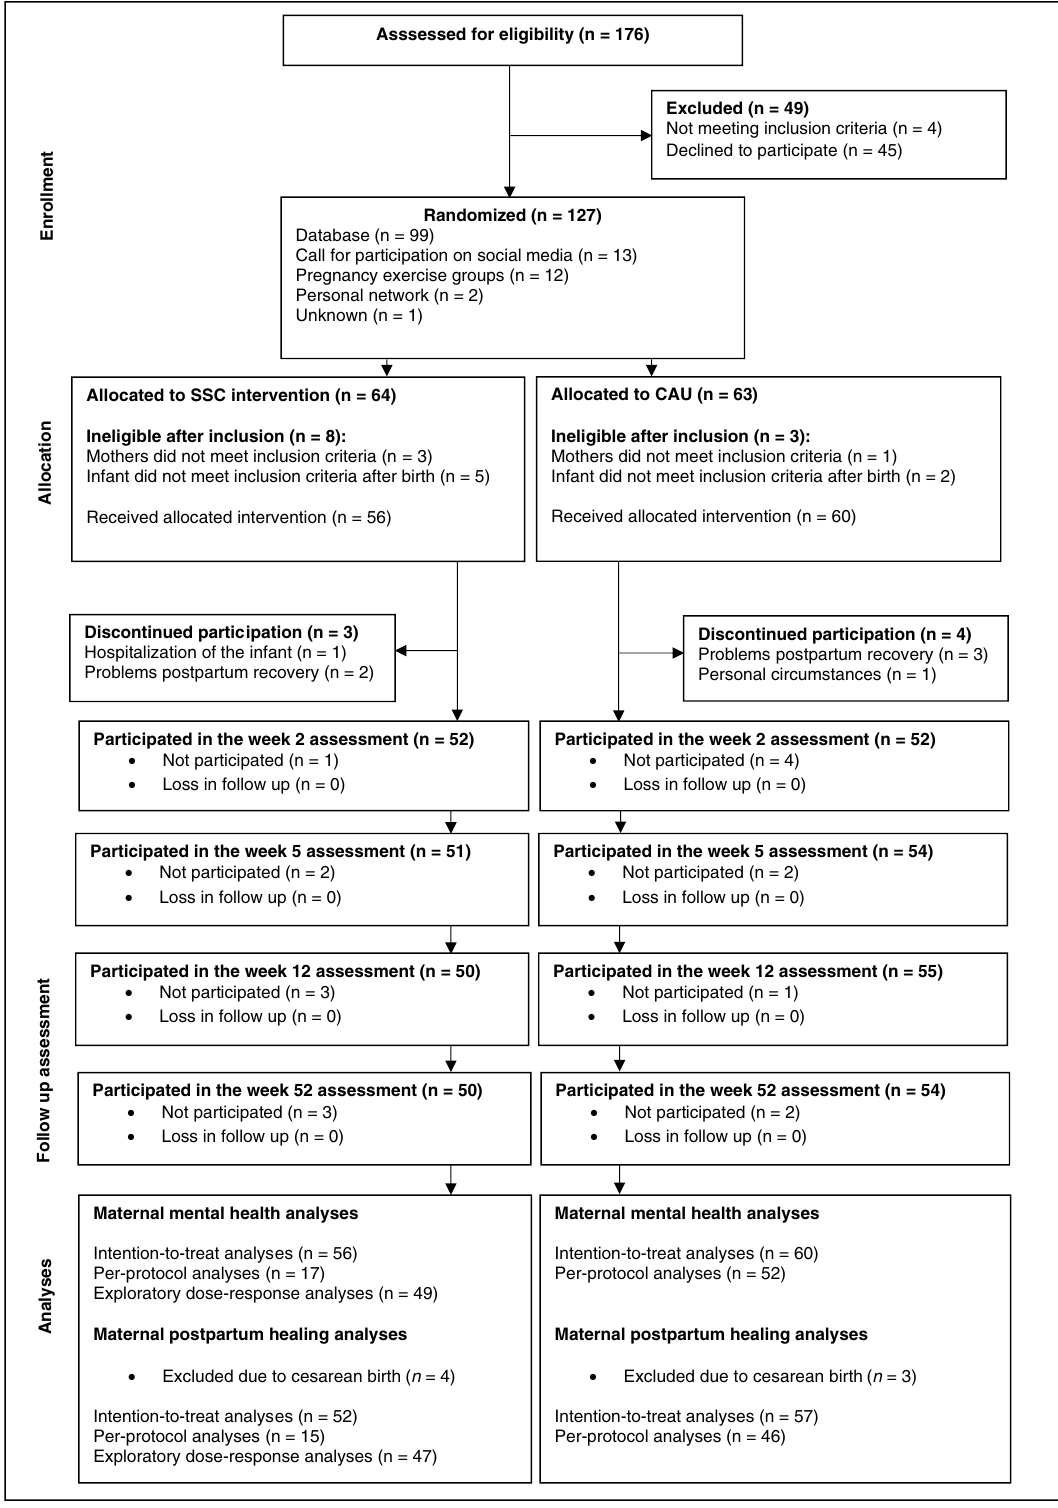
Figure 1. Flow diagram, including participant numbers through each stage of the trial. Numbers represent mothers that participated in the measurement round but do not define the number of mothers that actually filled out the maternal mental health and postpartum healing questionnaires. SSC, skin-to-skin contact; CAU,